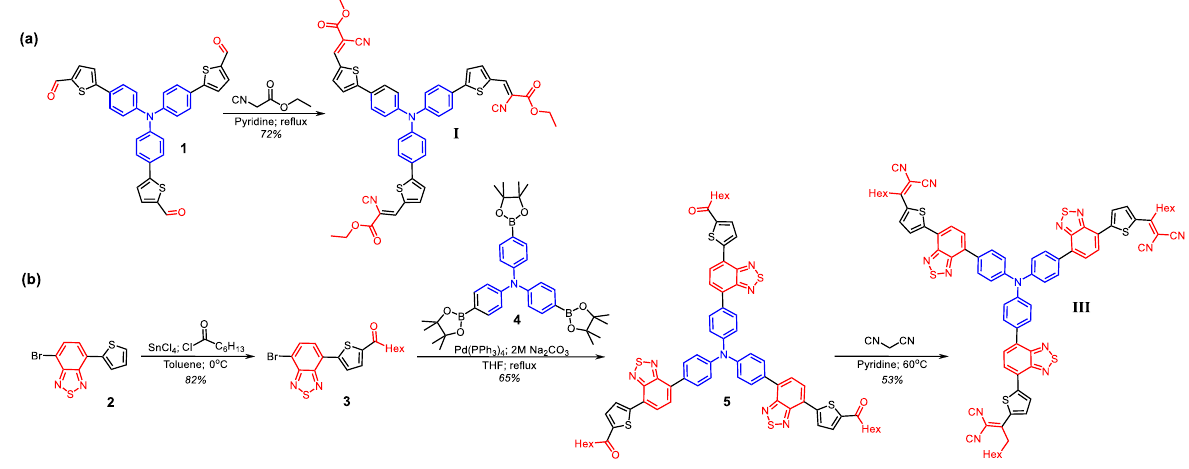
Scheme 1. Synthetic route for target molecules I ( a ) and III ( b ).